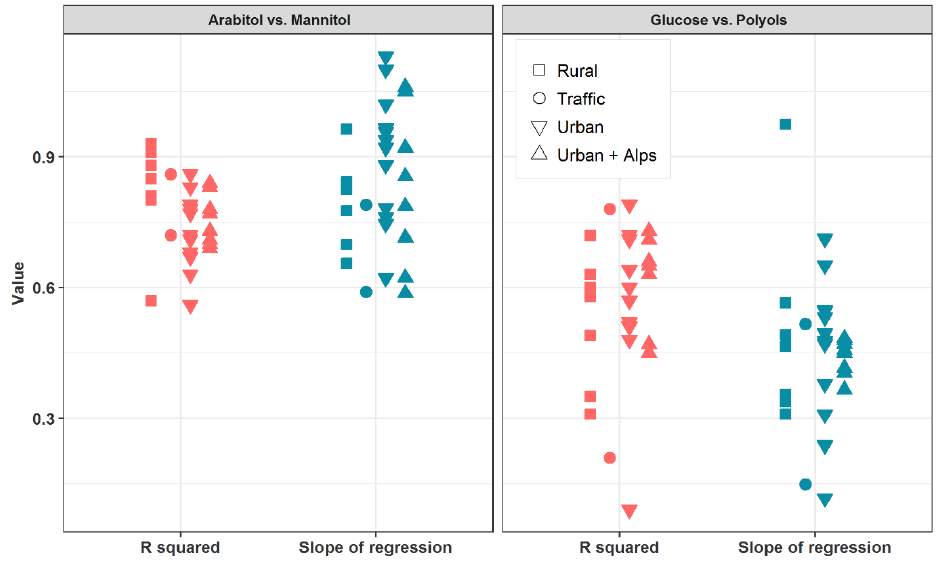
Figure 4. Linear regression analysis between selected primary sugar compound mass concentrations (i.e., arabitol, mannitol, and glucose) during summer and autumn seasons (June to November) for all the sites considered in this study.